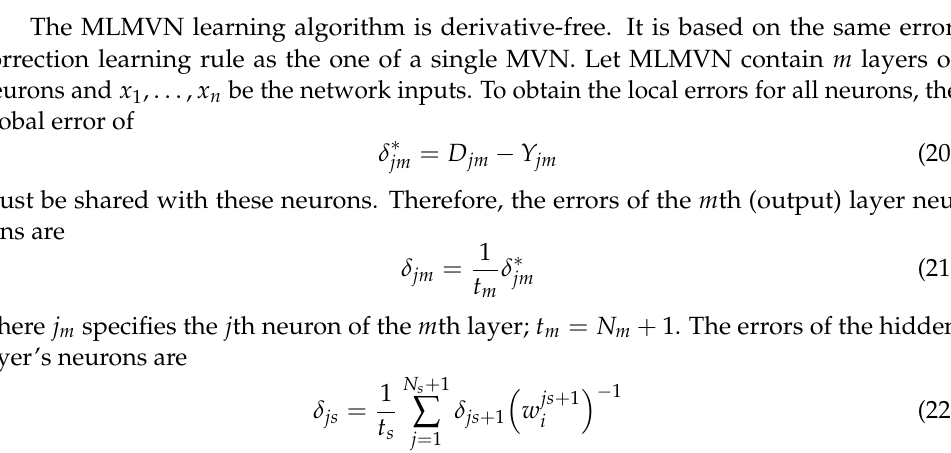
Figure 3. MVN training based on error-correction rule.